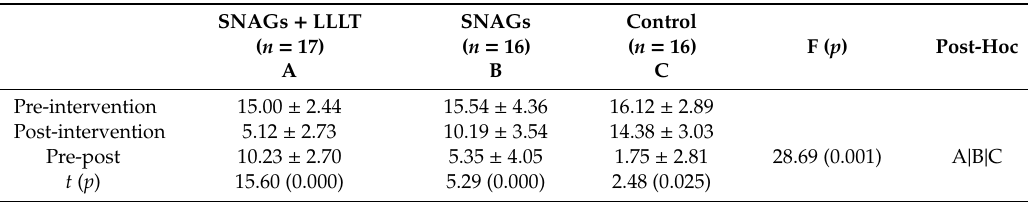
Table 4. Di ff erence on function ( N =